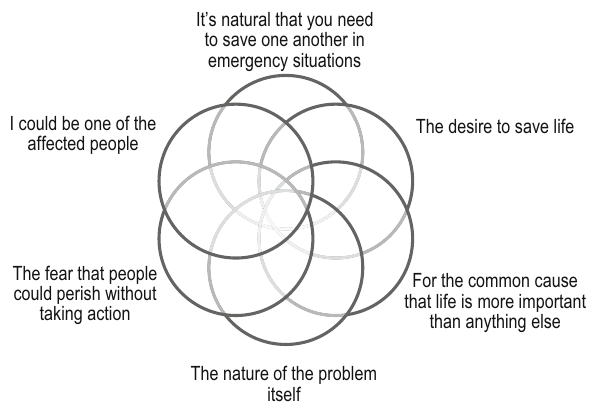
Fig. 3 Mapping motivational factors of community rescuers in Kopa Growth Point, Chimanimani District, Zimbabwe. Source : Partici- pants’ responses in 2019 field interviews and